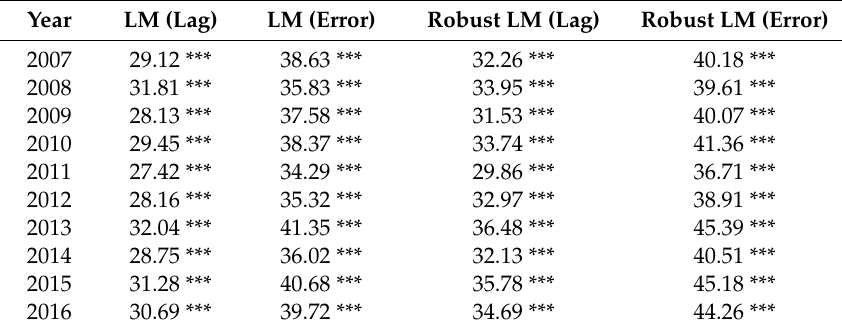
Table 4. Lagrange multiplier (LM) test